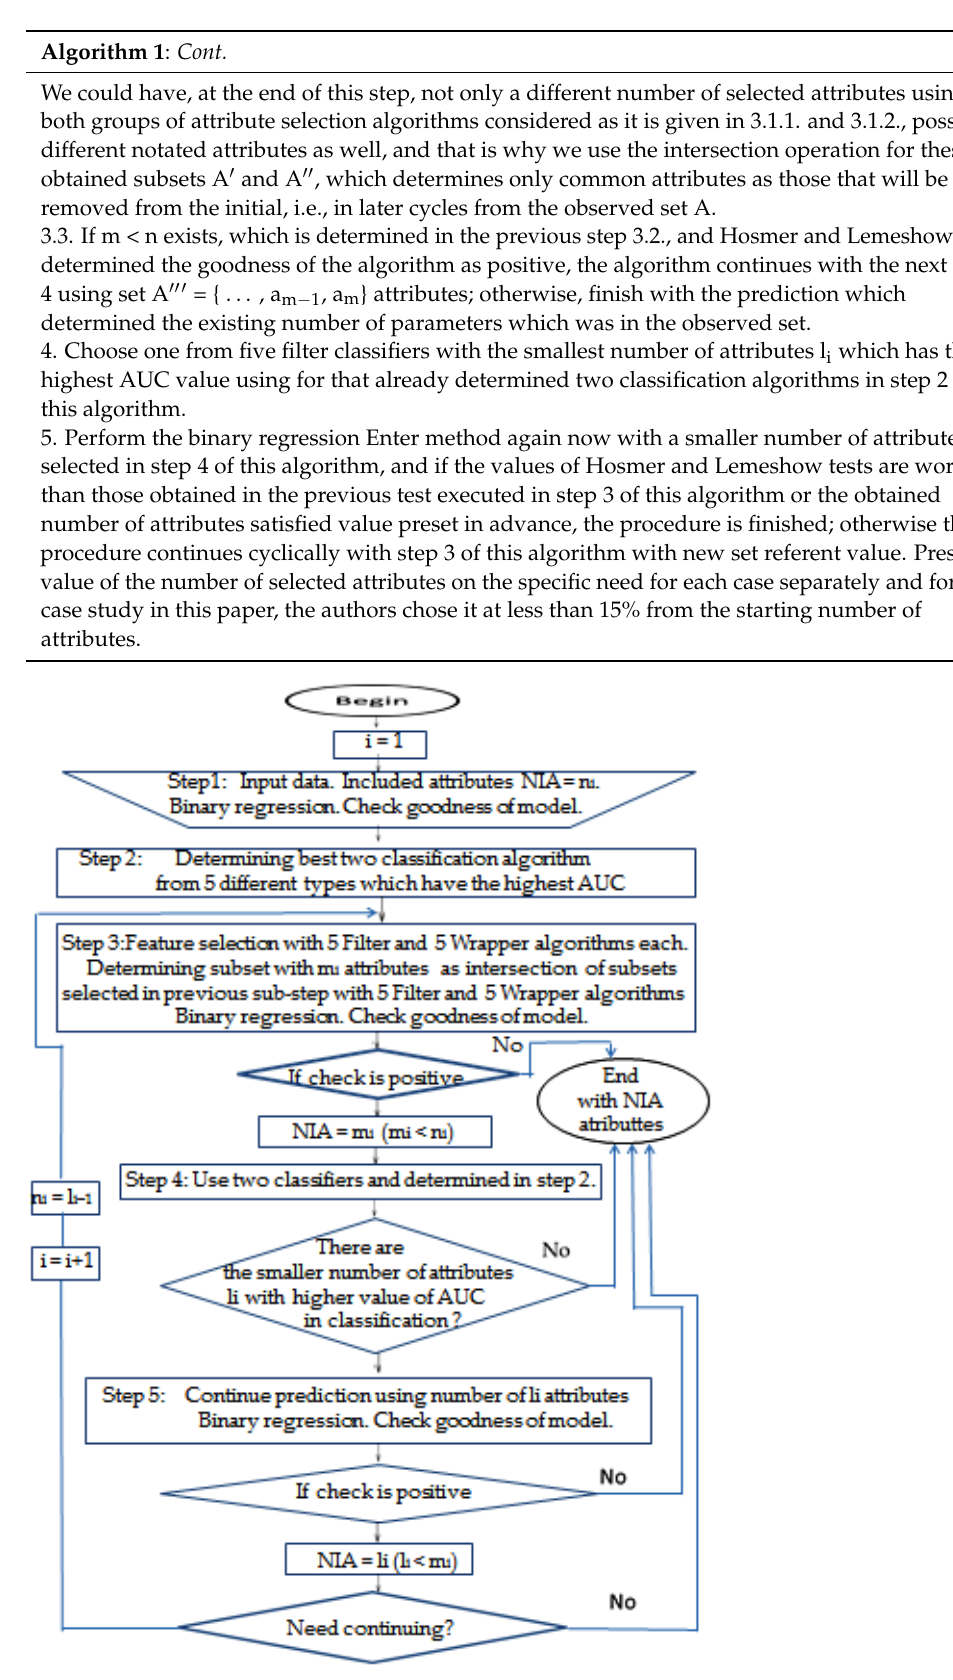
Figure 1. Block schema for the procedure which is described with Algorithm 1.